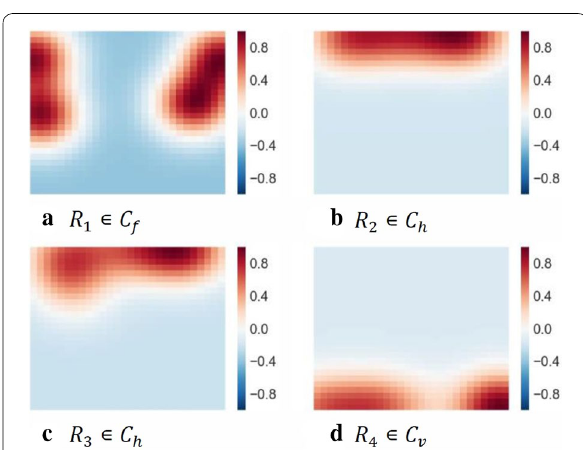
Fig. 18 Identification results of arrangement patterns based on the BoW